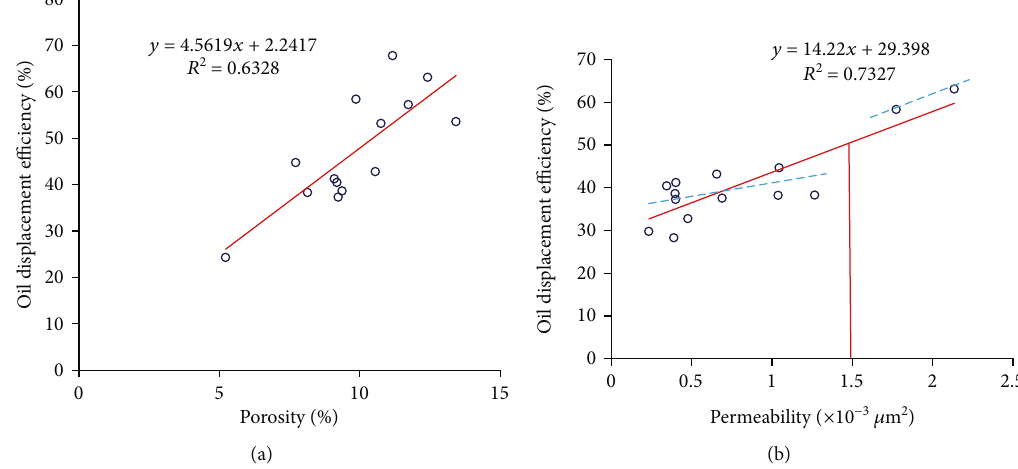
Figure 6: The relationship between physical parameters and oil displacement e ffi ciency..